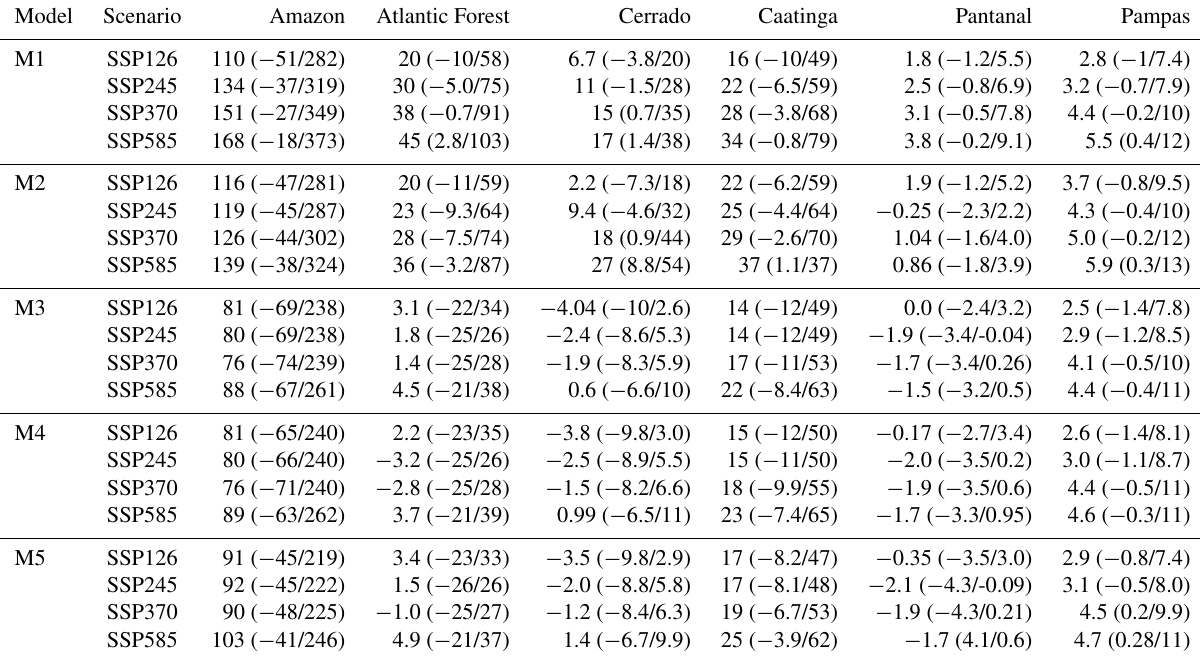
Table A5. Climate-change-scenario-specific estimates of DOM change (2001–2100) by DALEC for each of the Brazil biomes (Fig. 1). Units are PgC and values in parentheses are the 5% and 95% quantiles defining the 90% confidence interval. For clarity, values are rounded to the nearest PgC or two significant figures. SSP126 indicates SSP1-2.6Wm − 2 , SSP245 indicates SSP2-4.5Wm − 2 , SSP370